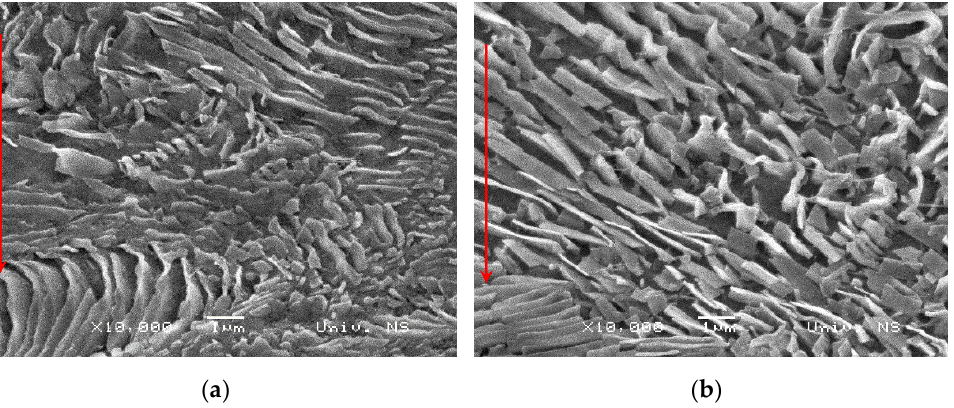
Figure 16. Microstructure of specimen in Zone I ( a ) and Zone IV ( b ) for strain level ε z 2 = 0.75 (red arrow—direction of upsetting).